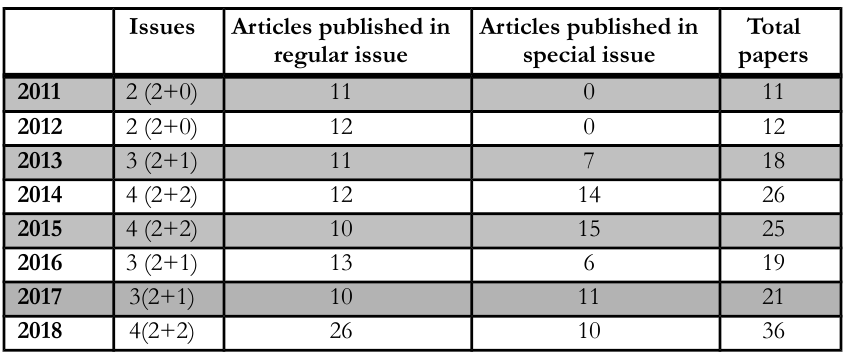
Table 2. Articles published evolution from 2010 to 2018